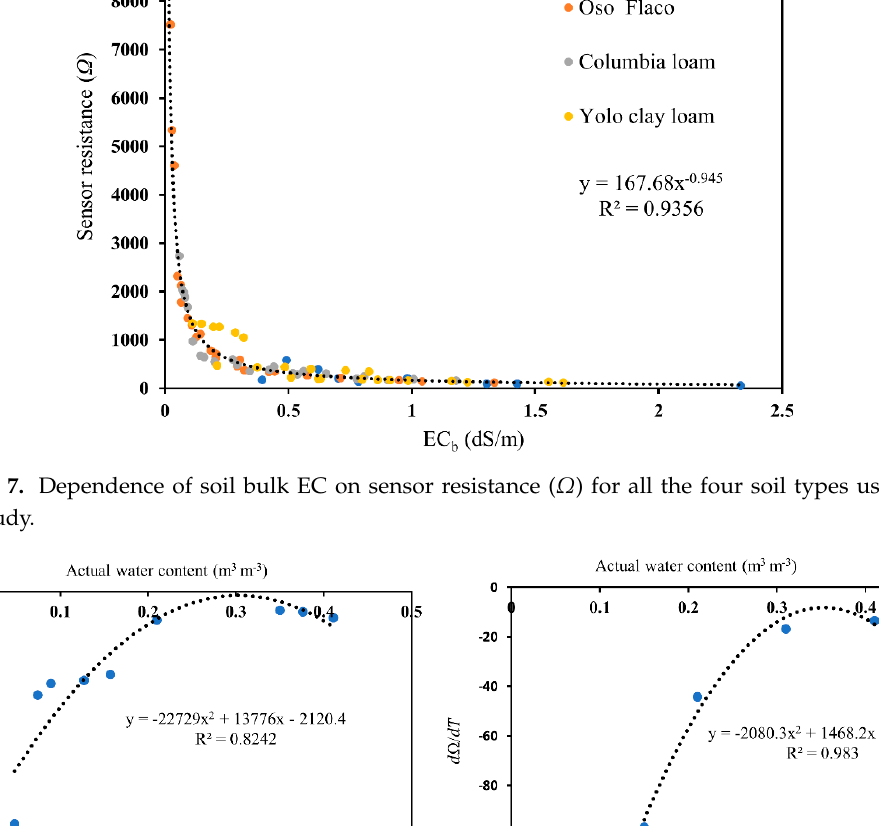
Figure 8. Dependence of d Ω / dT on water content at ( a ) 0.5 dS / m salinity, and ( b ) 1 dS / m salinity level. Figure 8. Dependence of 𝑑Ω 𝑑𝑇⁄ on water content at ( a ) 0.5 dS/m salinity, and ( b ) 1 dS/m salinity The d Ω / dT value is the slope of the linear response of sensor resistance to T in Figure level. The 𝑑Ω 𝑑𝑇⁄ value is the slope of the linear response of sensor resistance to T in Figure 6.